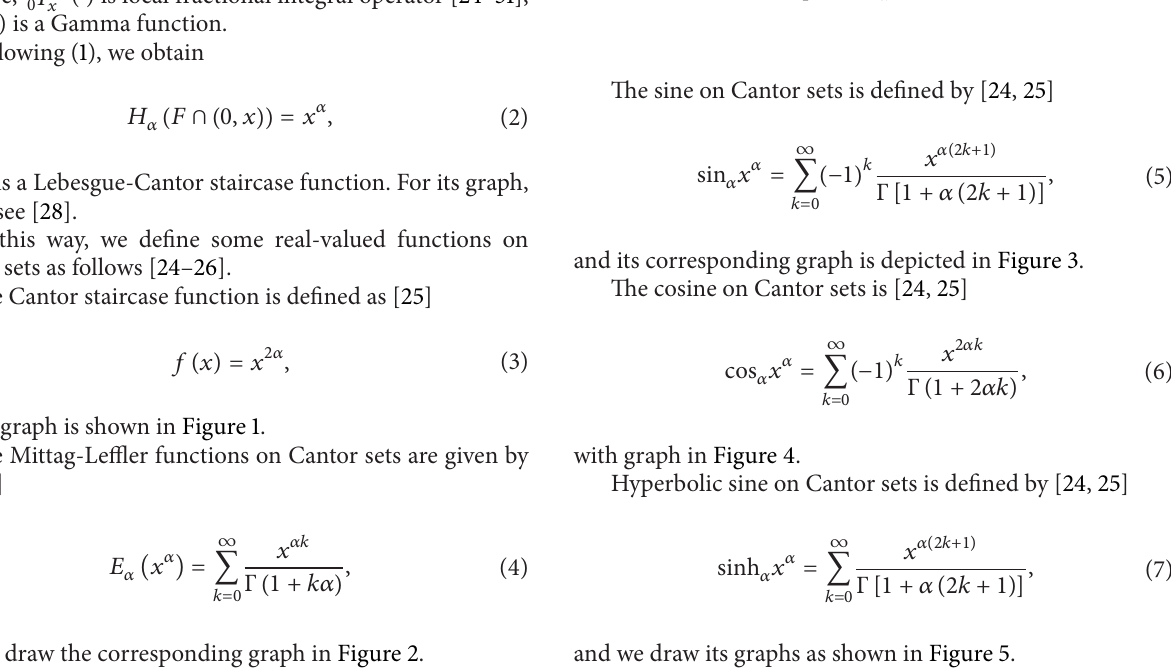
Figure 3: Graph of sin 𝛼 𝑥 𝛼 for 𝛼 = ln 2/ ln 3